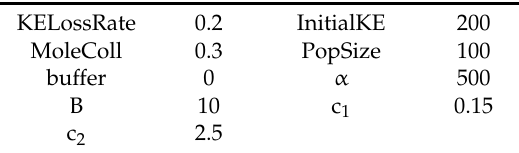
Table 1. Parameter settings of CRO algorithm.